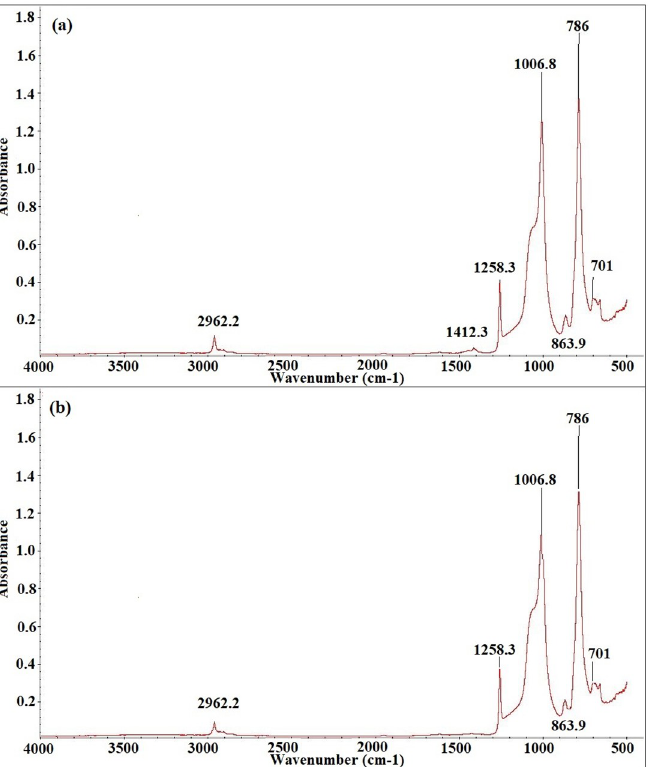
Fig 12. Spectrograph for SN2 a) Before aging, b) After aging.